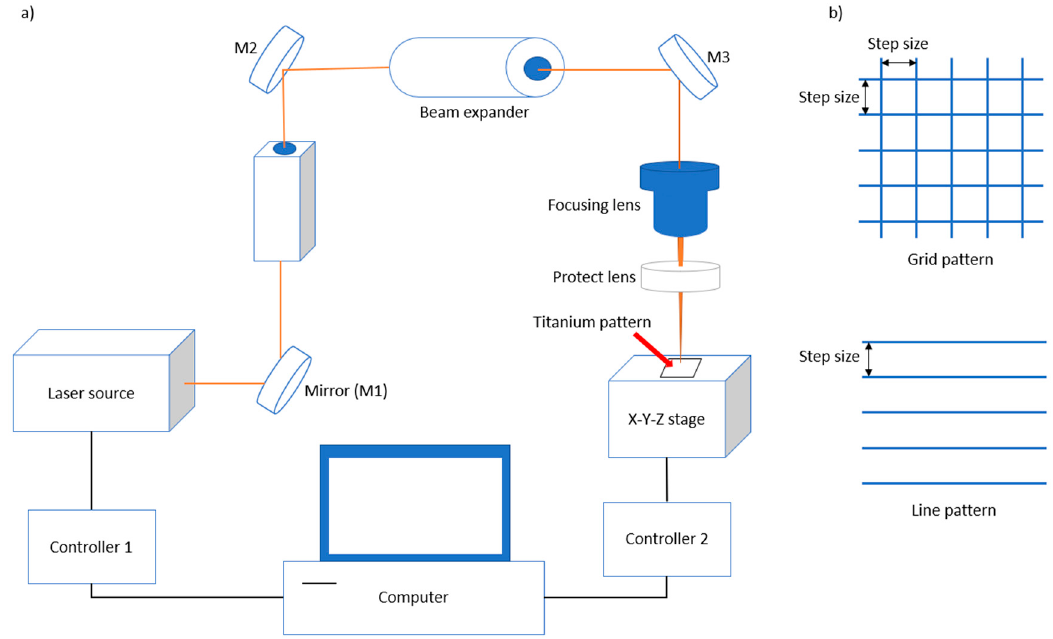
Figure 1. Schematic images of ( a ) the laser beam machining system; and ( b ) pattern design.